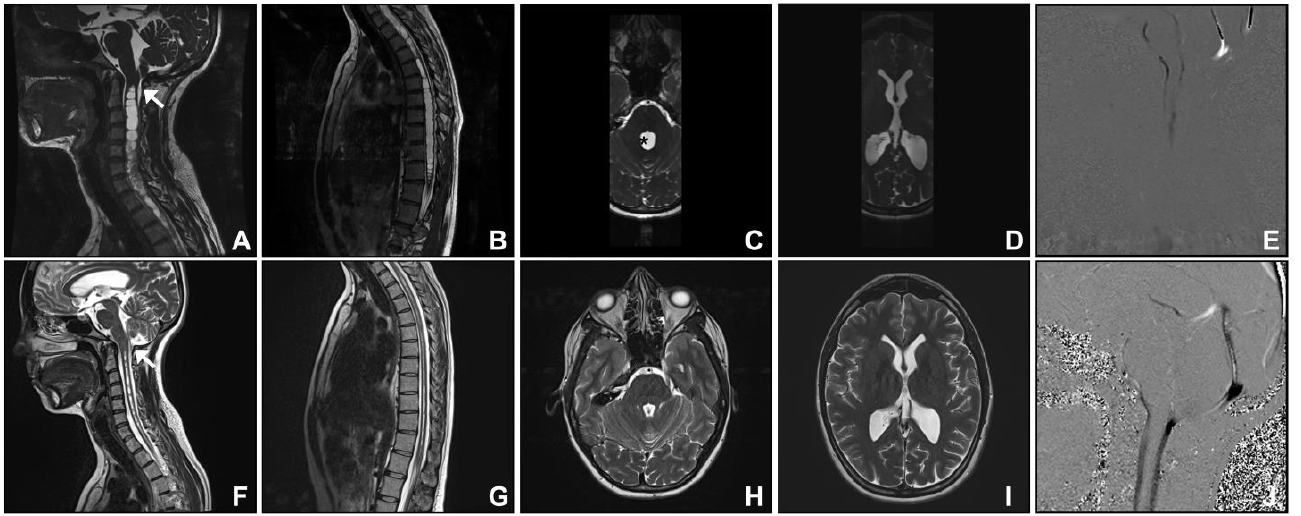
Figure 1 . Chiari mimic: post-traumatic cranio-cervical junction arachnoiditis. A 26-year-old woman presented with a history of premature birth and a prolonged period in the neonatal intensive care unit. Investigations revealed what appeared to be a Chiari I malformation with a holocord syringomyelia ( A , B ). Additional magnetic resonance imaging (MRI) features include septa at the cervico-medullary junction consistent with cranio-cervical junction arachnoiditis (( A ); white arrow), enlarged fourth (( C ); * for enlarged fourth ventricle) and lateral ventricles ( D ), and a lack of dorsal cerebrospinal fluid (CSF) flow evident on phase contrast CSF flow studies ( E ). Posterior fossa decompression and shunting of the fourth ventricle to the spinal subarachnoid space was undertaken (( F ); white arrow for shunt). At follow-up, there was full resolution of the symptoms in addition to reduction in syrinx size ( G ) and the fourth and lateral ventricles’ size ( H , I ), and established dorsal CSF flow on phase contrast CSF flow studies ( J ).